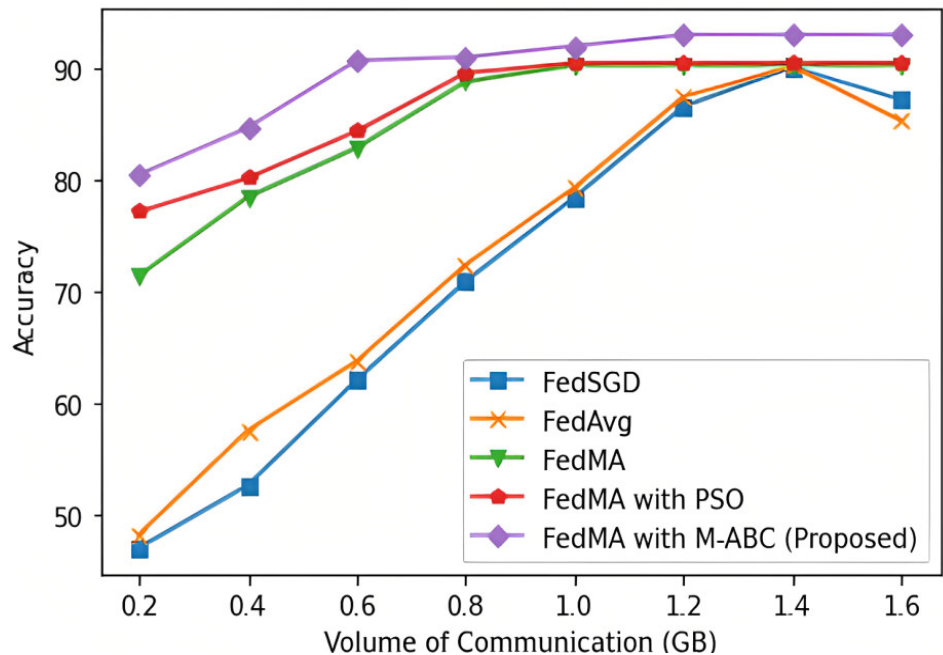
Figure 4. Effect of Accuracy on Amount of Communication.